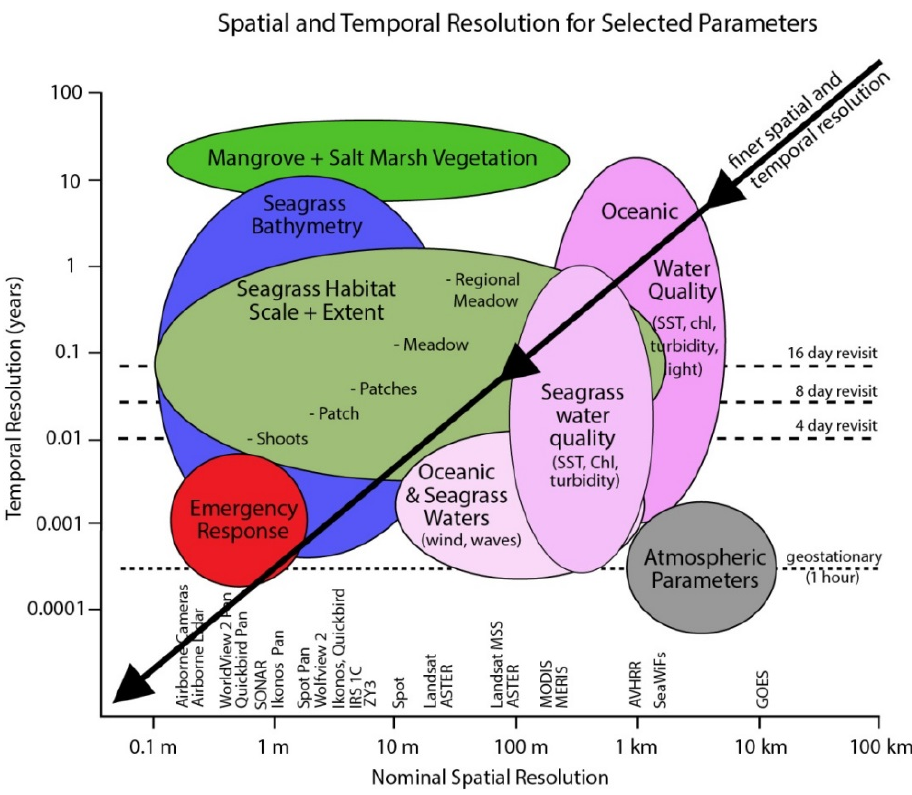
Figure 1. Spatial and temporal scales of coral reef mapping and monitoring application in relation to the pixel size and temporal frequency of commercially available airborne and satellite image data (source [35,36]).